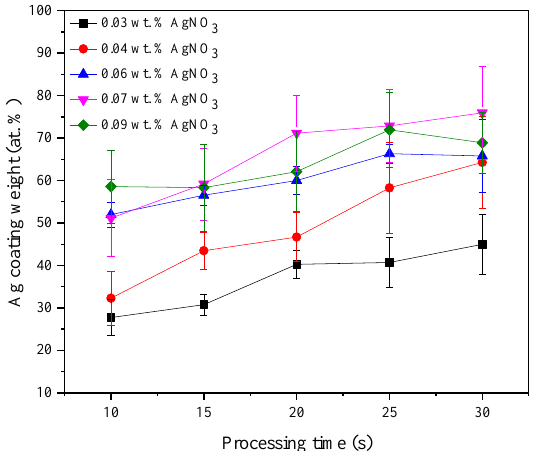
Figure 8. Comparison of the measured values and standard deviations of silver coating weight for different AgNO 3 concentrations and processing times, when KNO 3 concentration of 5 wt.% and an electrode distance of 20 mm are fixed.